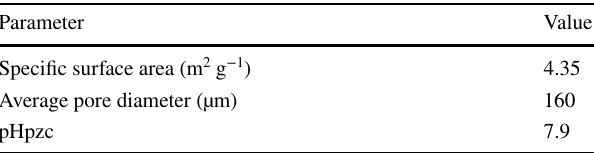
Table 1 The physicochemical characteristics of the Posidonia oce- anica Parameter Value